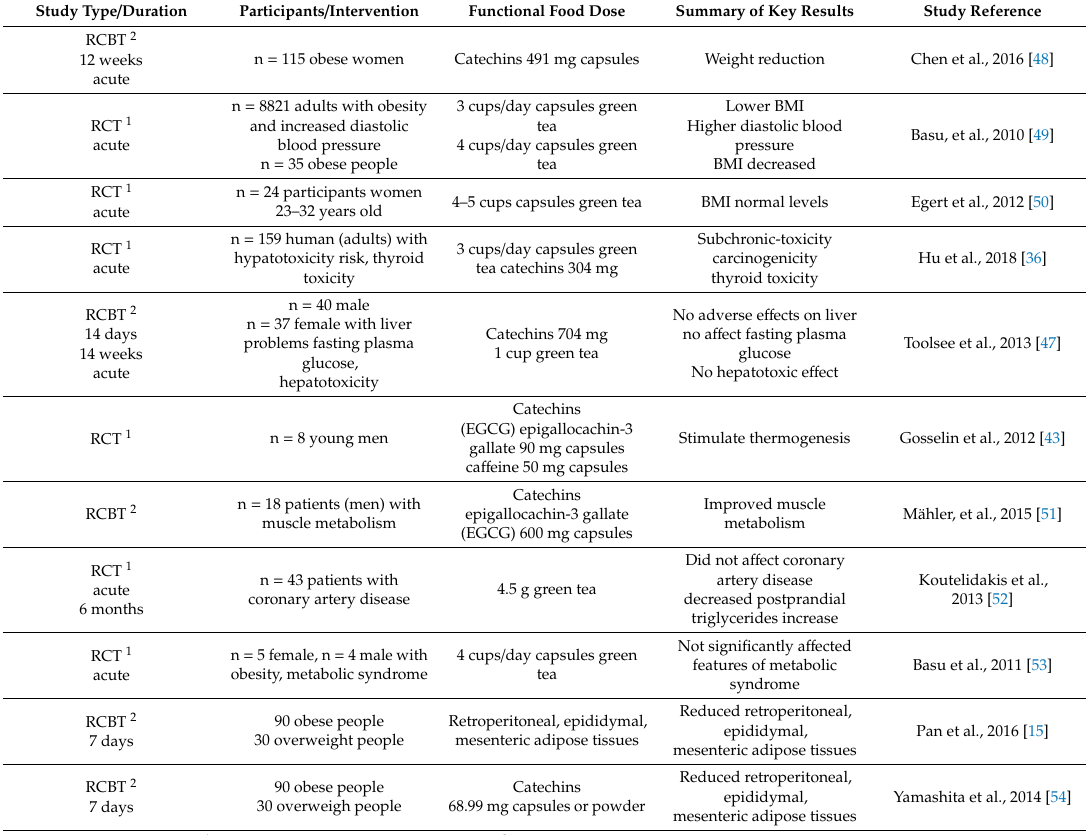
Table 3. Human intervention clinical studies about the possible e ff ects of green tea on body weight control, obesity and its metabolic